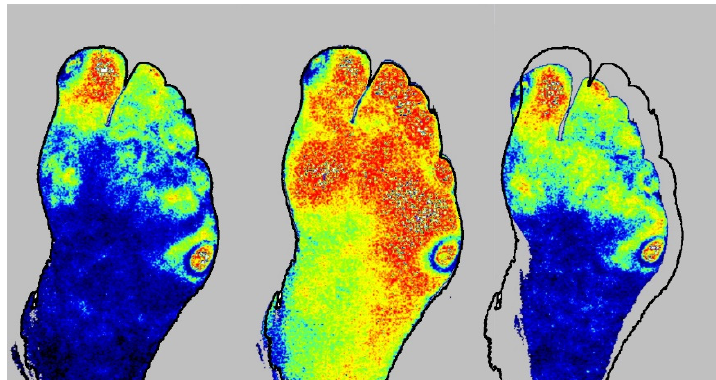
Figure 5. ROI tracking during baseline measurement ( left ), Post-Occlusive Reactive Hyperaemia test ( middle ), and Buerger’s test ( right ). Here, the ROI during Buerger’s test was erroneous, illustrating the need for redrawing the ROIs.